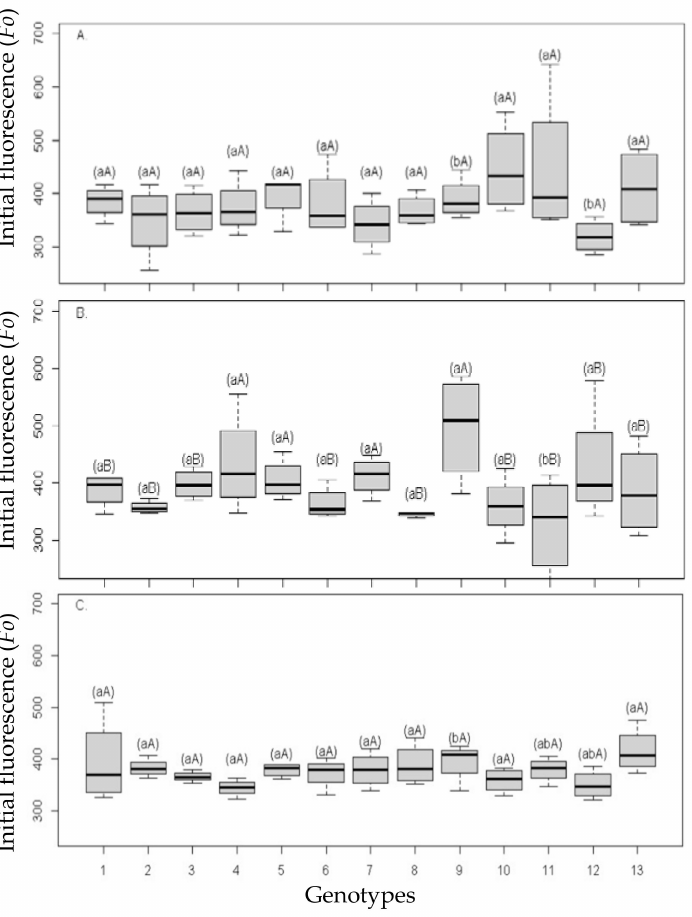
Figure 8. Boxplot relative to the average initial fluorescence (F0) of 13 citrus rootstocks in combination with ‘Tahiti’ acid lime ( Citrus × latifolia (Yu. Tanaka) Tanaka) under irrigation with waters of 0.14 ( A ), 2.40 ( B ), and 4.80 dS m − 1 ( C ), in the second year. For identification of genotypes, see Table 1. Boxplots with the same lowercase letter do not differ statistically, according to the Tukey test between salinity levels ( p ≤ 0.05), and those with the same uppercase letter belong to the same genotype group, according to the Scott–Knott test ( p ≤